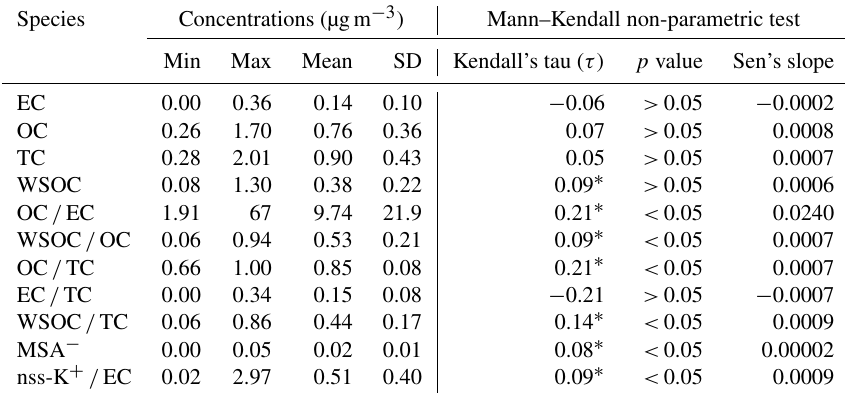
Table 3. Statistical report on the annual trends in carbonaceous aerosols and their ratios during 2001–2012 at Chichijima in the western North